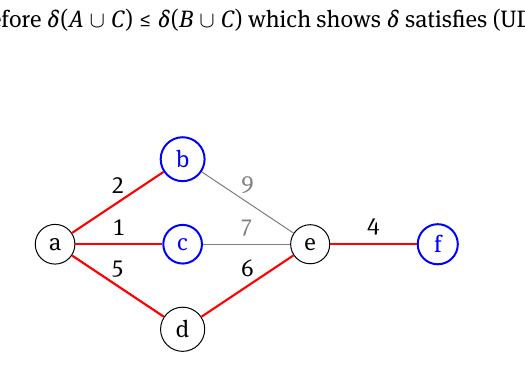
Figure 1: In the finite connected graph G with edge weights indicated by the numbers near the edges, the blue vertices b , c and f indicate a subset A of the set of all vertices { a , b , c , d , e , f } . The red tree S spans A and has maximum edge weight 6 , while any other spanning tree over A has maximum edge weight greater than 6